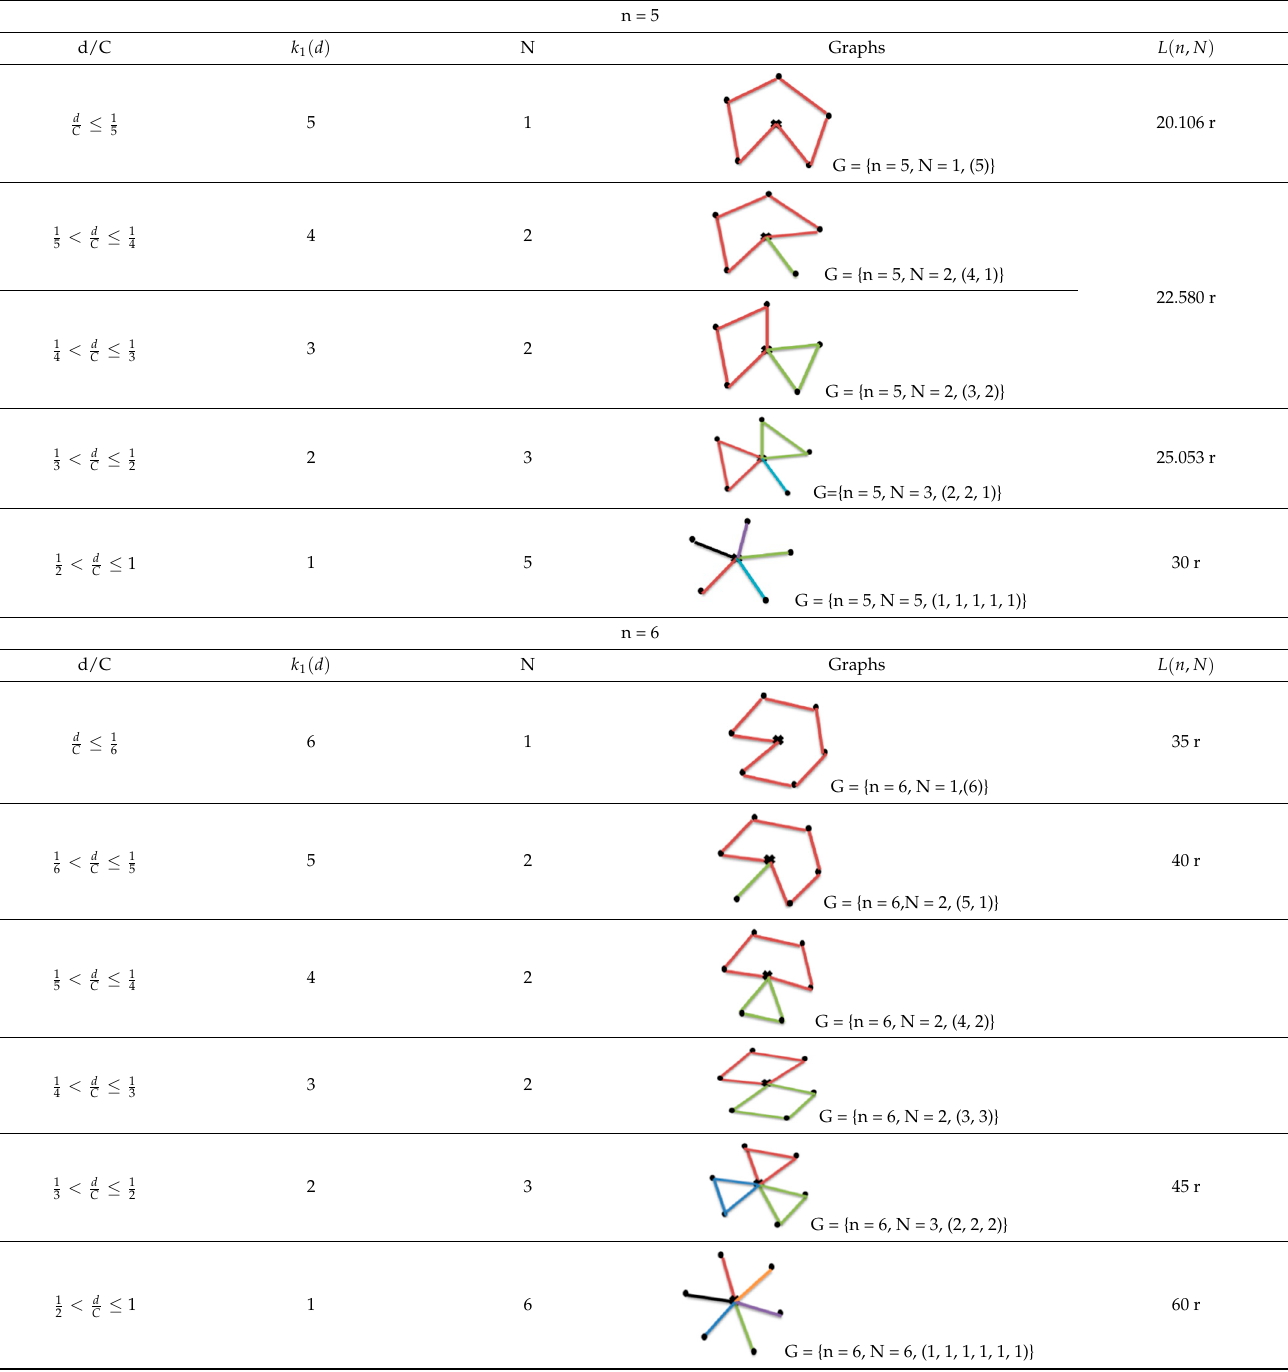
Table A1. Domains of d, corresponding graphs and lengths L (n, N) of the paths travelled by the set of optimum number of drones necessary for the logistics distribution, when zone contains n = 5, and 6 vaccination centres, respectively.